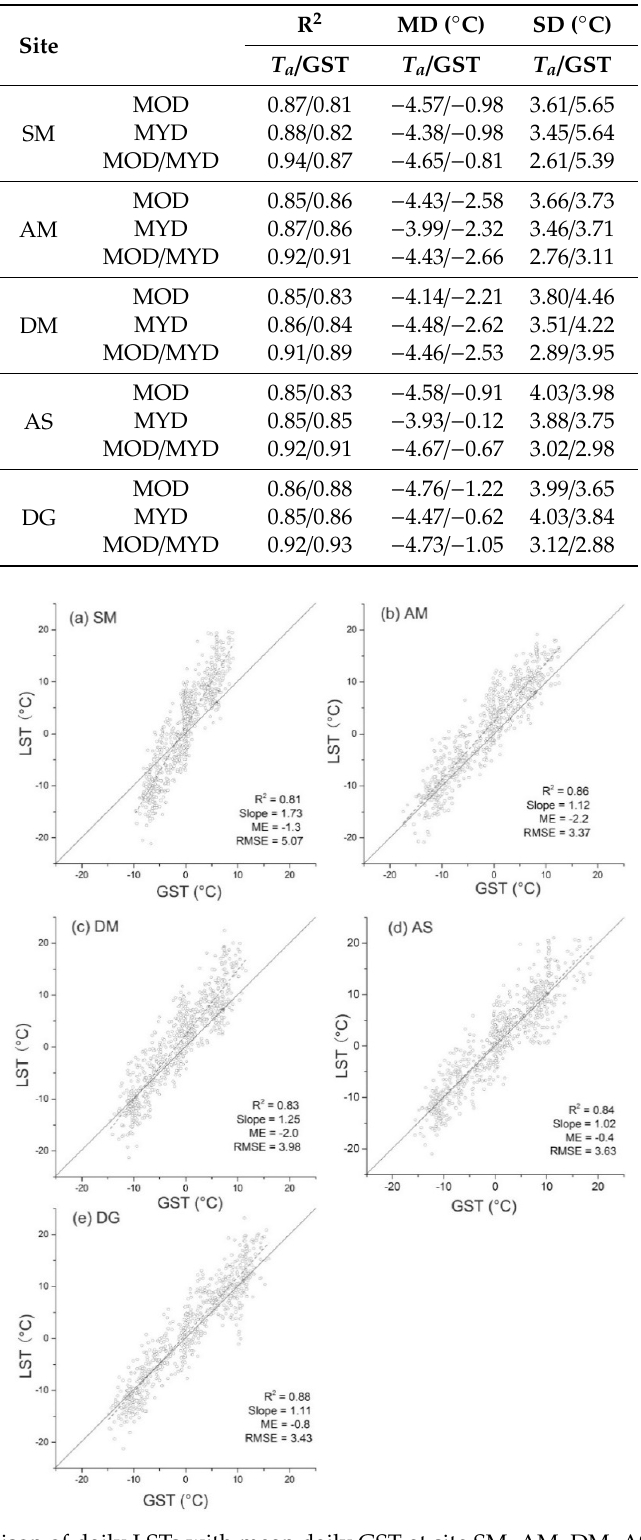
Table 2. Statistics of Correlation Coefficient ( R 2 ), Mean Difference (MD), Standard Deviation (SD) between LST and AT/GST for daily average from Aqua (MOD) and Terra (MYD) separately, and Aqua/Terra (MOD/MYD) combined.